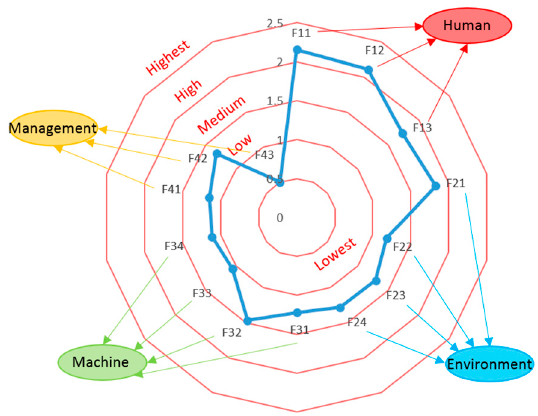
Figure 8. The risk radar diagram.